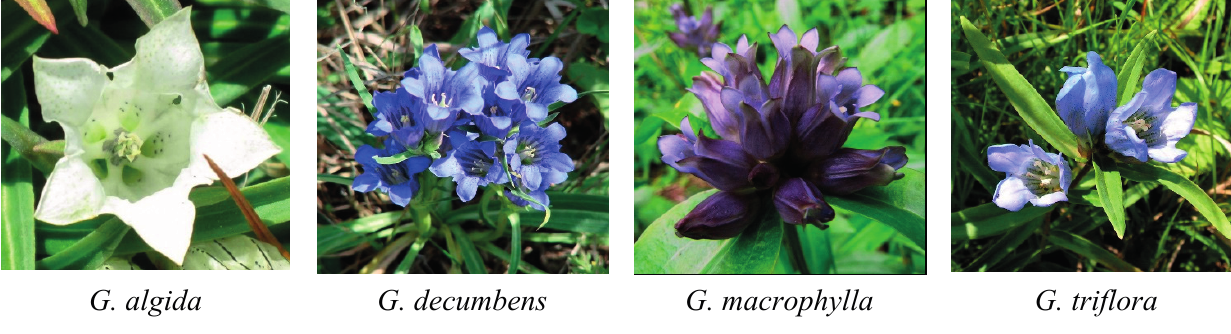
Figure 1. Gentians used in Siberia as bitter